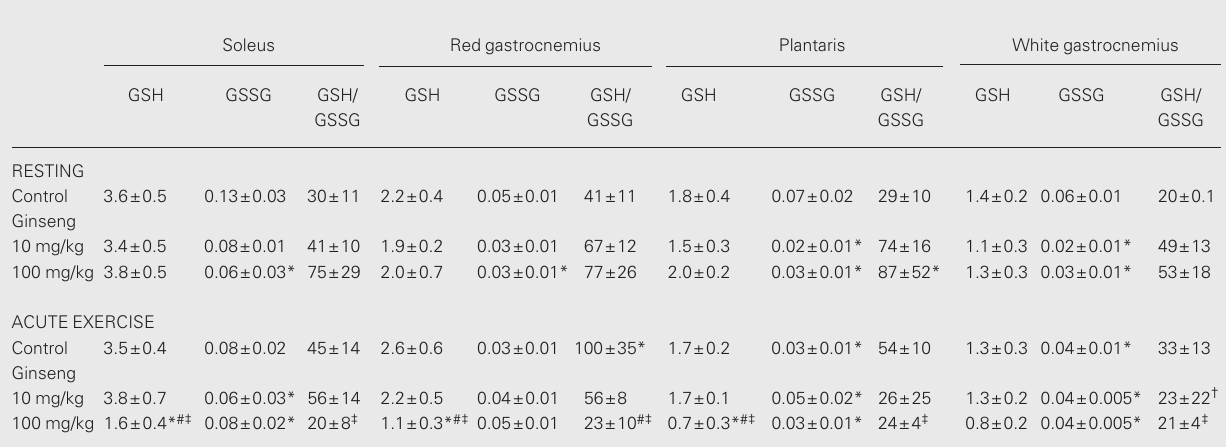
Table 2. Glutathione content of rat soleus, gastrocnemius (red and white) and plantaris skeletal